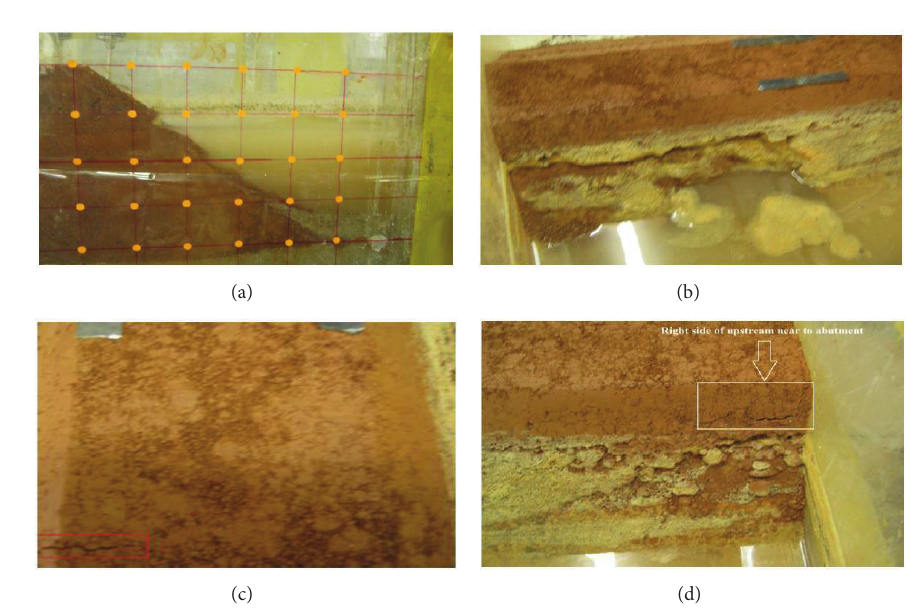
Figure 21: Damage in the second model (Model